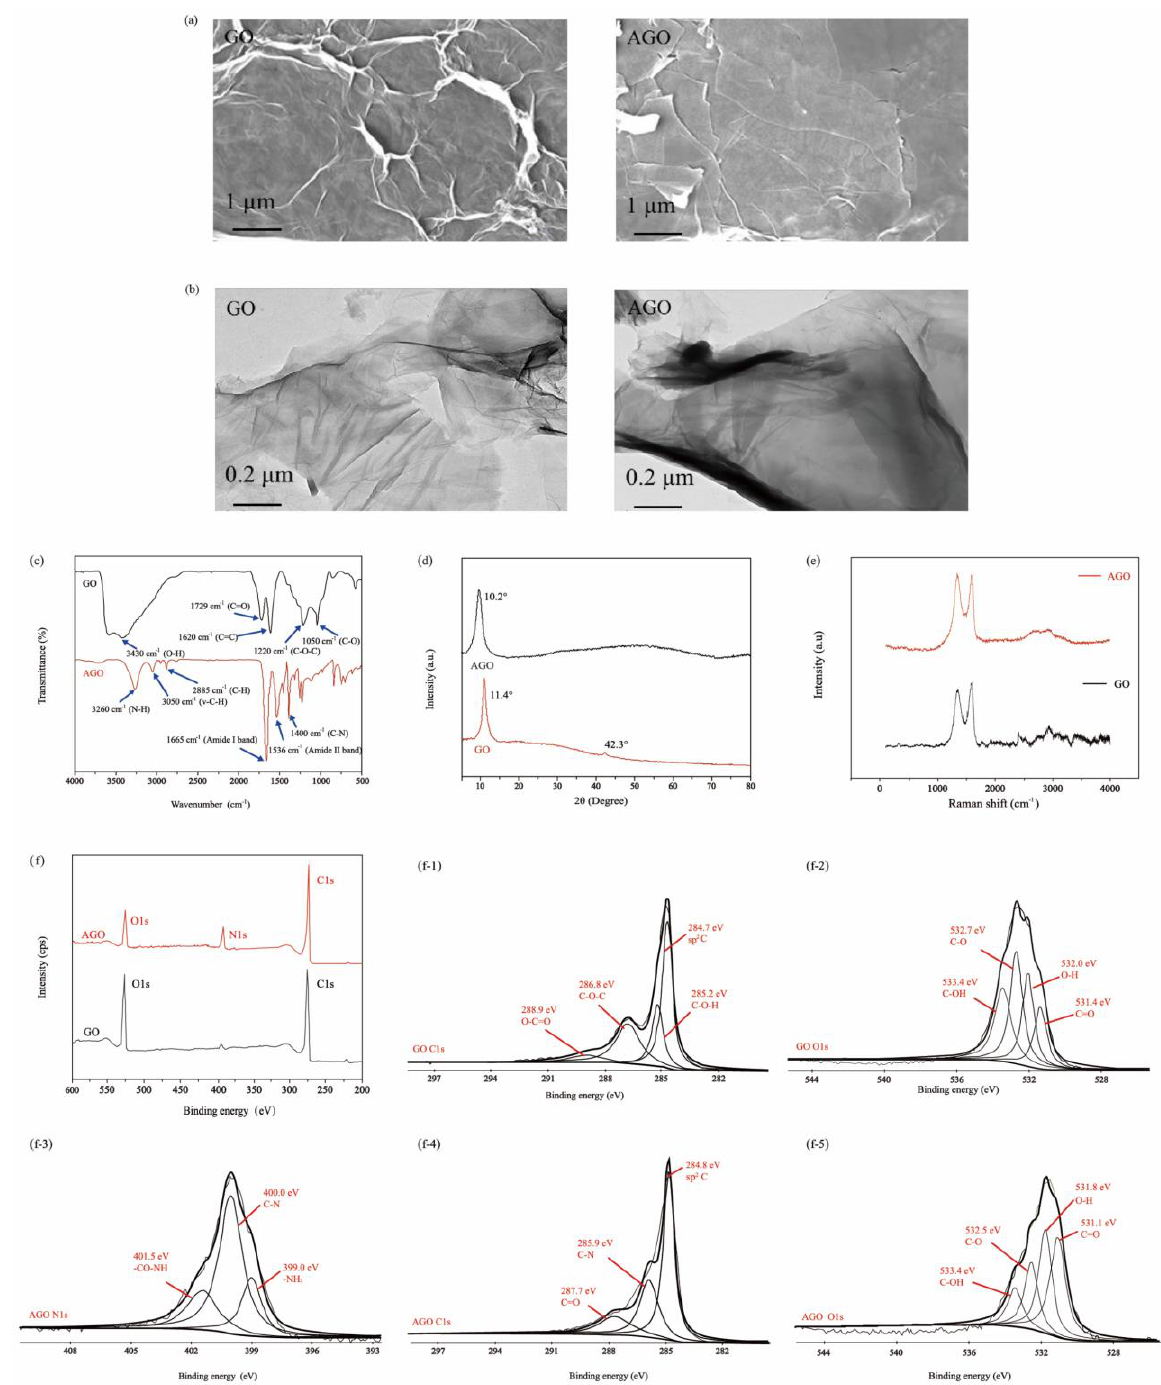
Figure 1. Characterization of amidated graphene oxide (AGO). ( a ) SEM, ( b ) TEM, ( c ) FTIR spectra, ( d ) XRD pattern, ( e ) Raman spectra, ( f ) XPS survey spectra, ( f-1 ) C1s spectra of GO, ( f-2 ) O1s spectra of GO, ( f-3 ) N1s spectra of AGO, ( f-4 ) C1s spectra of AGO, and ( f-5 ) O1s spectra of AGO.